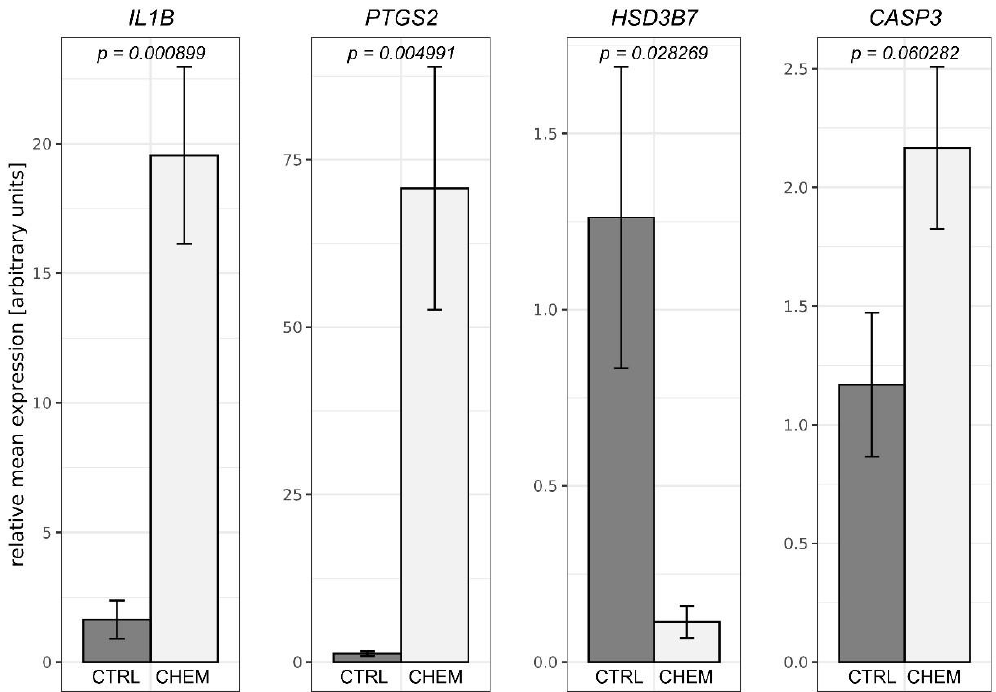
Figure 7. Quantitative real-time PCR validations of RNA-Seq results performed for selected di ff erentially expressed genes—interleukin 1 β ( IL1B ), prostaglandin-endoperoxide synthase 2 ( PTGS2 ), hydroxy- δ -5-steroid dehydrogenase, 3 β - and steroid δ -isomerase 7 ( HSD3B7 ) and caspase 3 ( CASP3 ). Above the bars, precise p -values obtained from statistical analysis of the results are written. CTRL is a control group and CHEM is a chemerin-treated